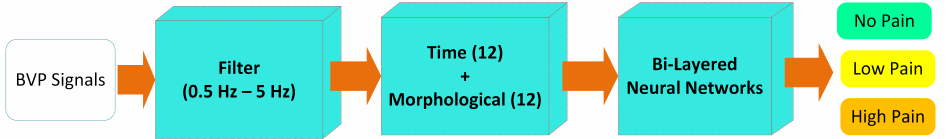
Figure 11. The proposed methodology for Experiment 3 (no pain vs. low pain vs. high